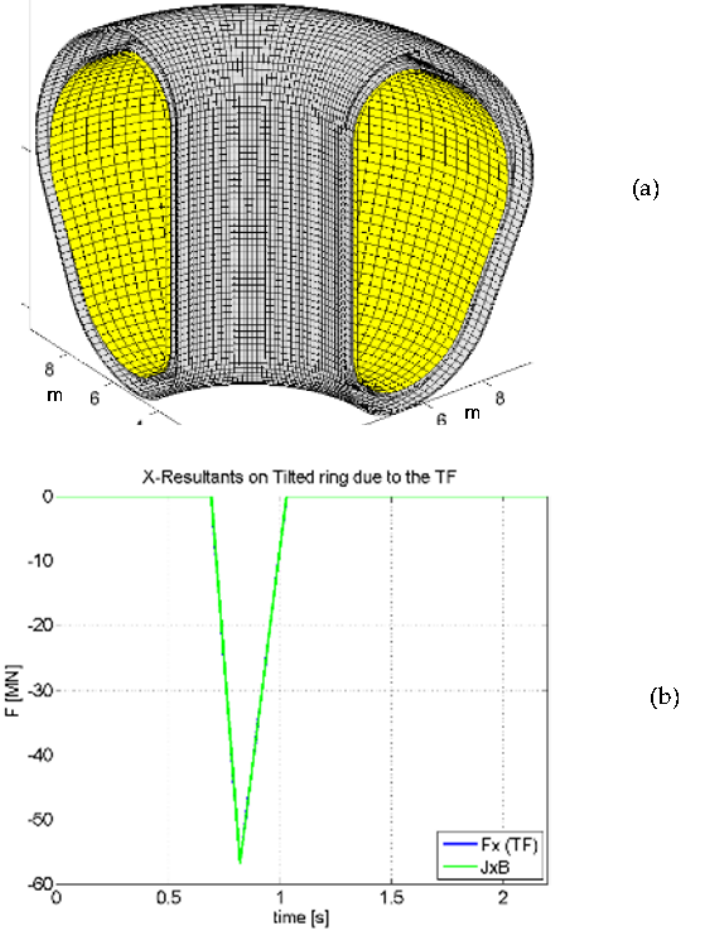
Figure 4. Case study 1: ( a ) one fourth of the double wall vacuum vessel and of the surface (in yellow) for the integration of the Maxwell stress tensor; ( b ) the time history of the x resultant on the tilted filament due to the toroidal field (TF). Table 3. Case study 1: speed-up values for task (c) with OpenMP–MPI on MARCONI Cluster. OpenMP